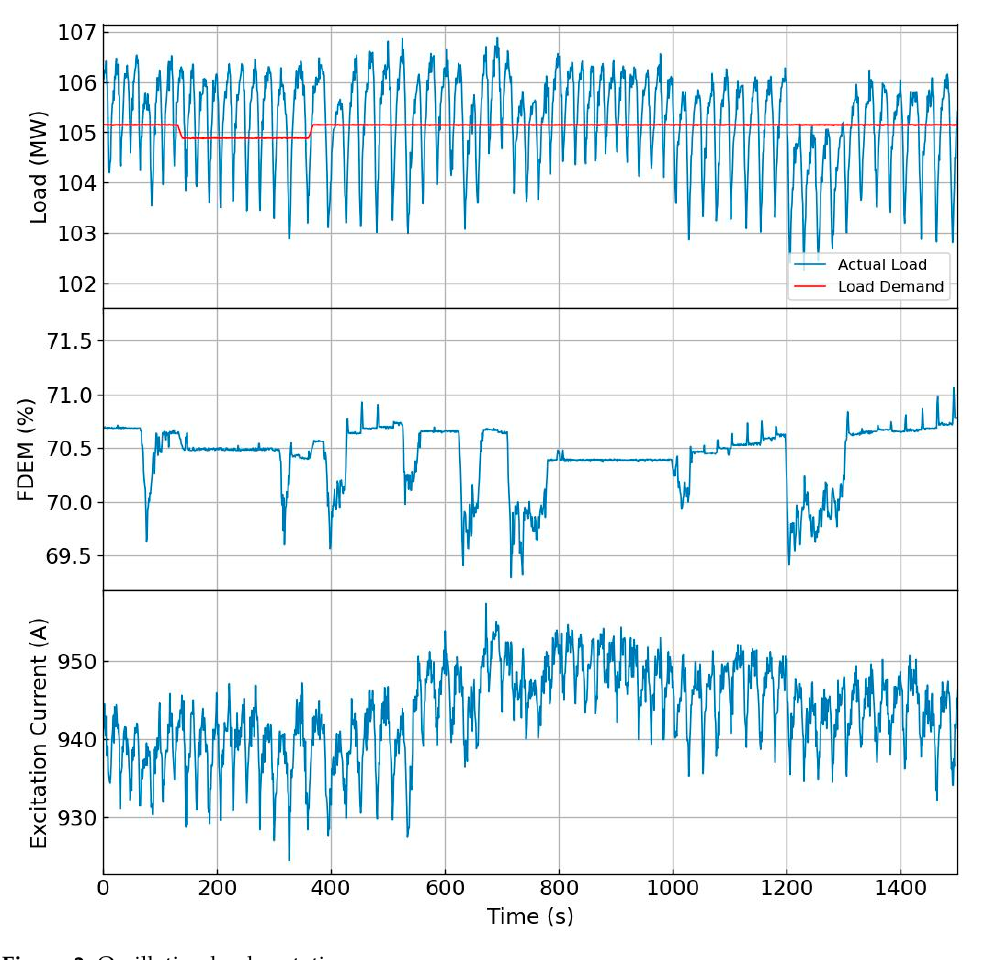
Figure 2. Oscillating load mutation. The above analysis allows us to extract a specific fault characteristic of load oscillation caused by electrical interference. When a fault with frequent load oscillation occurs, the unit load corresponds to a sine wave signal with 20 s and an amplitude of 0.6% Pe superimposed on the stable output of the unit’s thermal